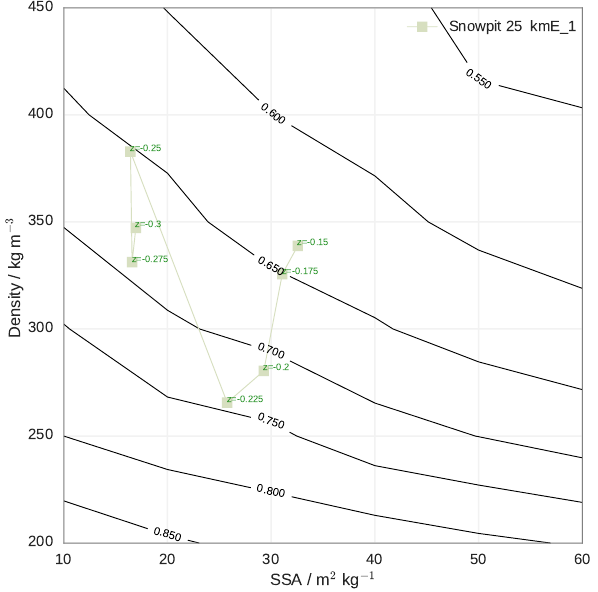
Figure 12. Ratio at 50cm depth (black contour lines) between the radiances calculated by MCML simulations with rod and without rod for a homogeneous snowpack with varying SSA and density. Low values of the ratio indicate high rod absorptions. Green sym- bols represent the couples (SSA, density) at several depths mea- sured in the 25kmE_1 snow pit.